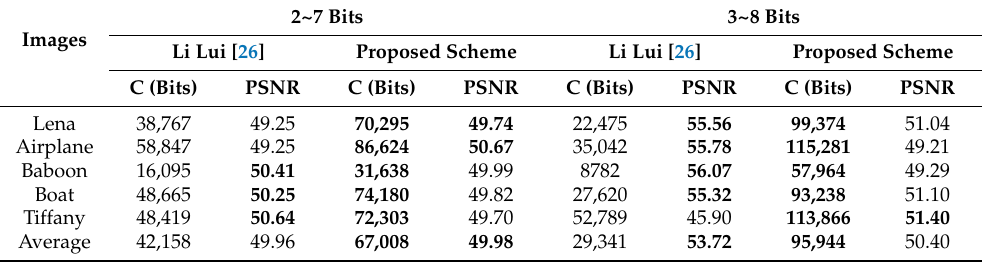
Table 6. Comparison of performance by selecting 6 bit-planes. Bold values shows the best result achieved by a scheme.